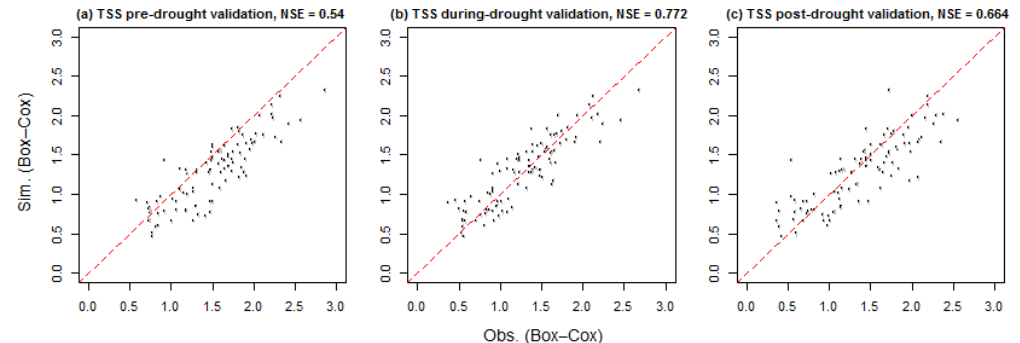
Figure 8. Comparison of the performance of the full spatiotemporal TSS model calibrated using all data across (a) the pre-drought (1994– 1996), (b) drought (1997–2009) and (c) post-drought (2010–2014) periods, as represented by the simulated versus observed site-level mean concentrations in Box–Cox-transformed space. The 95% upper and lower bounds of the simulations are shown using vertical gray lines, and red dashed lines show the 1 : 1